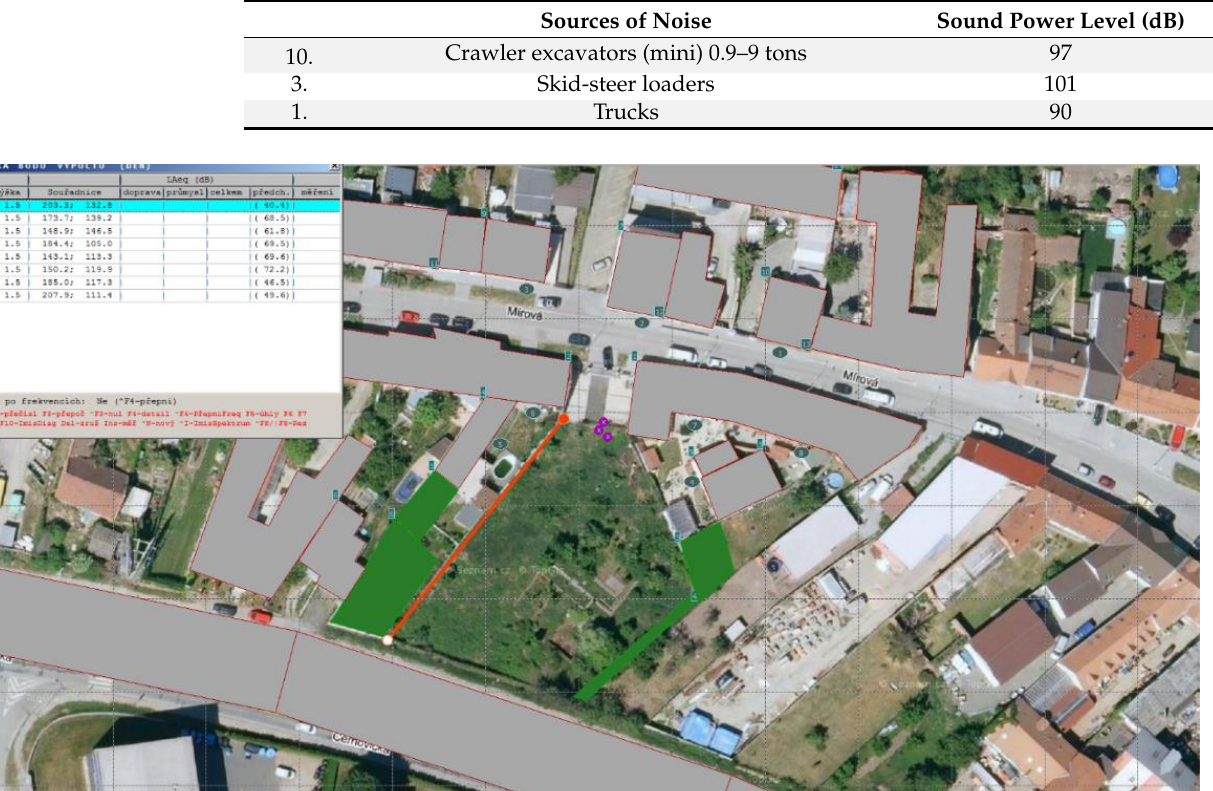
49.6 During the simultaneous deployment of all the needed machines, the limit values are exceeded at measured points 2, 4, 5, 6. Measures: Separate the excavation process and the removal of excavated material into separate cycles. In Figure 9, we see a table in the upper left corner, which is then enlarged and rewrit- ten in Table 9.